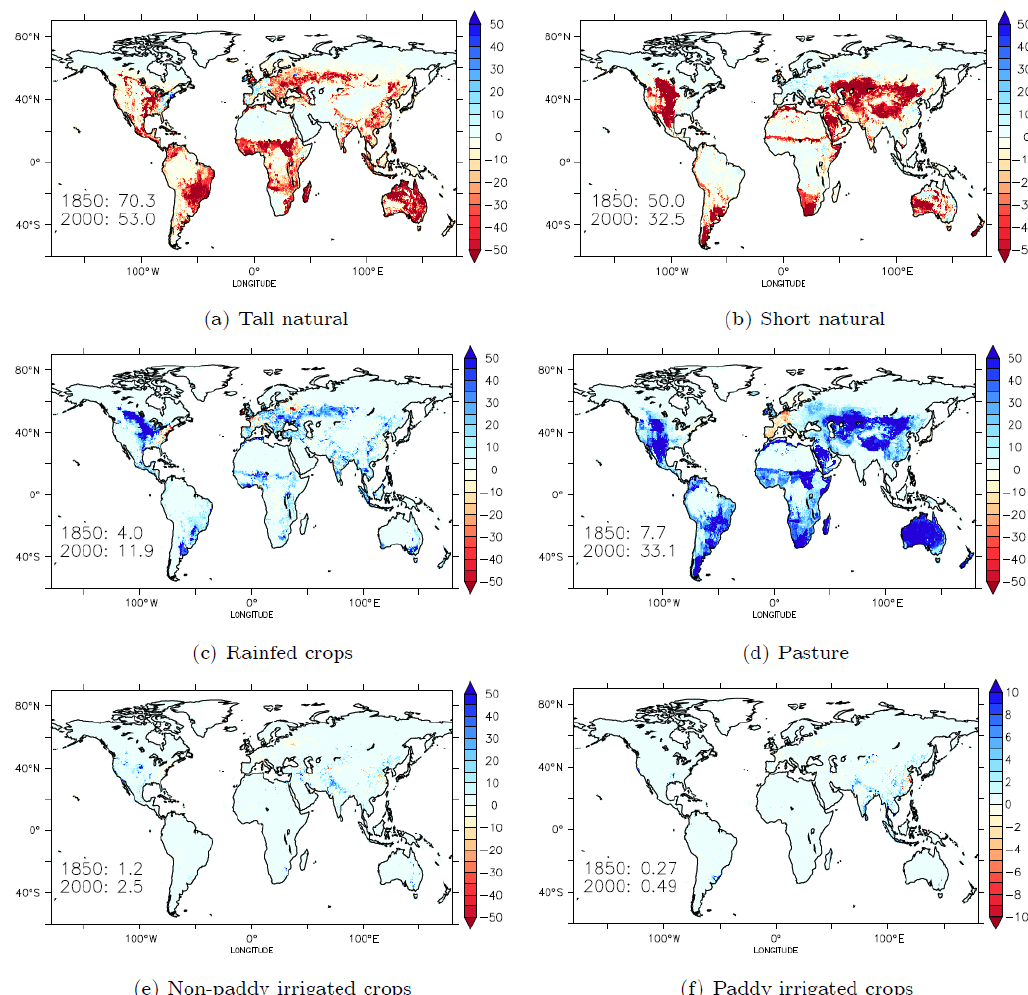
Figure 4. Changes in land cover in each of the six land cover classes, expressed in percentage of grid cells. Note that in panels (a–e) the scale reaches 50%, while in (f) , for paddy irrigated crops, it reaches 10%. The numbers indicate the surface area covered by a land cover type in 1850 and 2000 in 10 6 km 2 . Total land surface area in our experiments is 133 × 10 6 km 2 (Antarctica is excluded). In experiments LC1850 and LC2000 all crop fields are rainfed, only in HUM2000 do the paddy and non-paddy irrigated fields receive additional